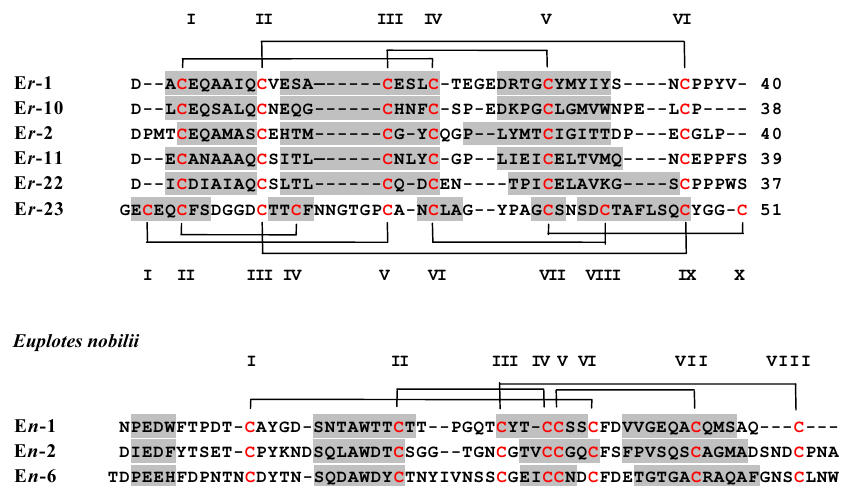
Figure 1. Amino acid sequences of E. nobilii and E. raikovi pheromones. The sequence alignment was maximized by insertion of gaps. Cysteines are marked in red and by progressive Roman numerals, and their pairing into disulfide bonds is indicated by brackets. The sequence regions involved in the formation of helical structures are shadowed. The PDB codes of the pheromone NMR and crystal (E r -1) structures are the following: E r -1, 1ERC, 1ERl; E r -2, 1ERD; E r -10, 1ERP; E r -11, 1ERY; E r -22,